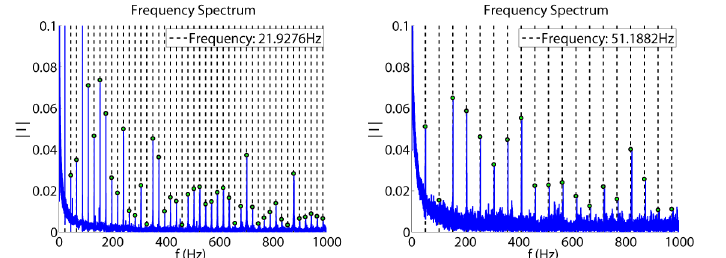
Fig 5. Frequency spectrum for u = 6V (a) and u = 14V